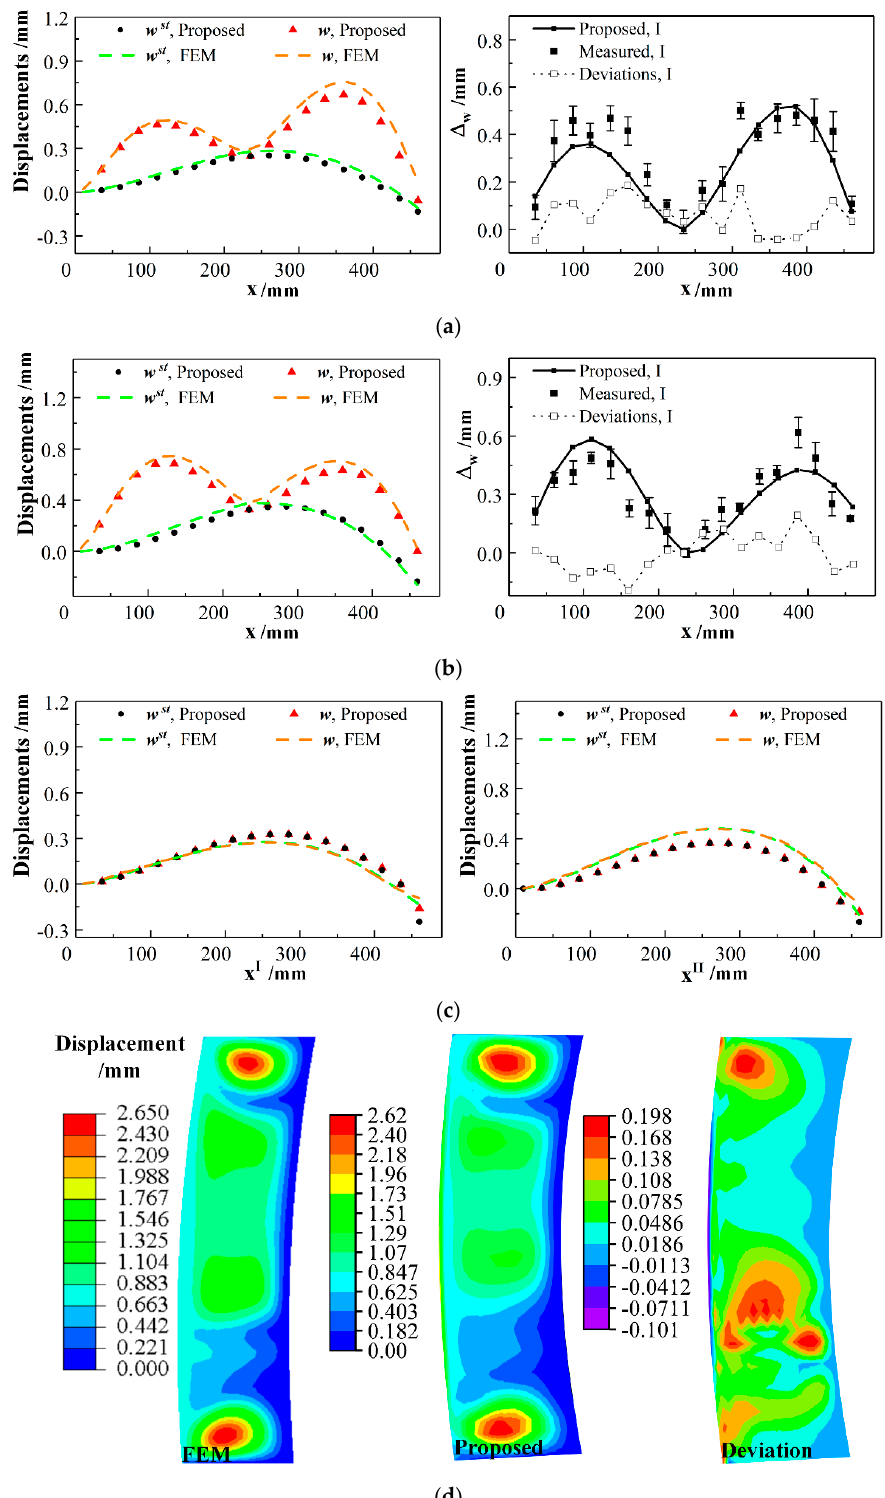
Figure 7. Deformation of stiffened panel with joints at different positions. ( a ) One joining point P 9I on stringer I; ( b ) one joining point P 9II on stringer II; ( c ) nine joining points on stringer I and nine joining points on stringer II; ( d ) magnitude of displacement given by FEM and proposed method and the deviation between